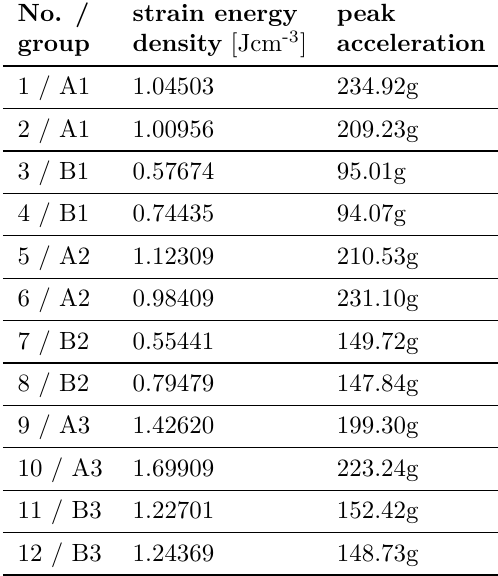
Table 2. Impact test